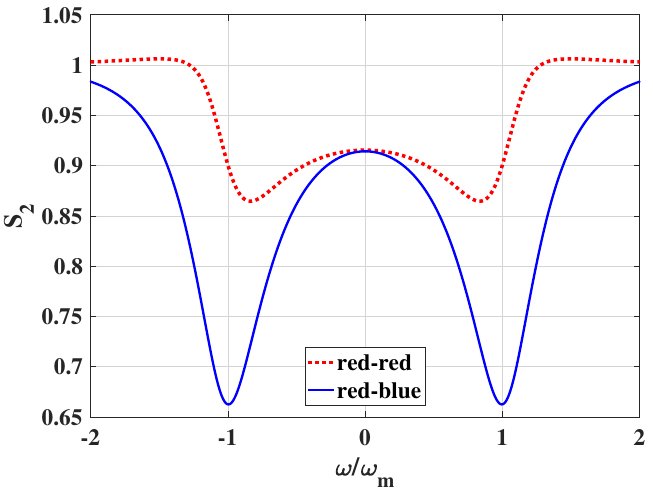
Figure 5. Squeezing spectrum of two output modes. The legend red-red represents both two optical tweezers in red sideband of the cavity mode. The legend red-blue denotes the optical tweezers A in red sideband while another tweezers B in blue sideband. The decay rates of the cavity mode are κ A = 0.3 ω m and κ B = 3 ω m . Two tweezers are different in wavelength λ A = 780 nm ( λ B = 980 nm). Other parameters are the same as Figure 3.